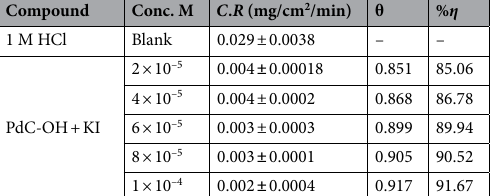
Table 4. Data of Wt. loss method for corrosion of carbon steel in 1 M HCl solution with and without KI + PdC-OH (M) at 25 °C ±